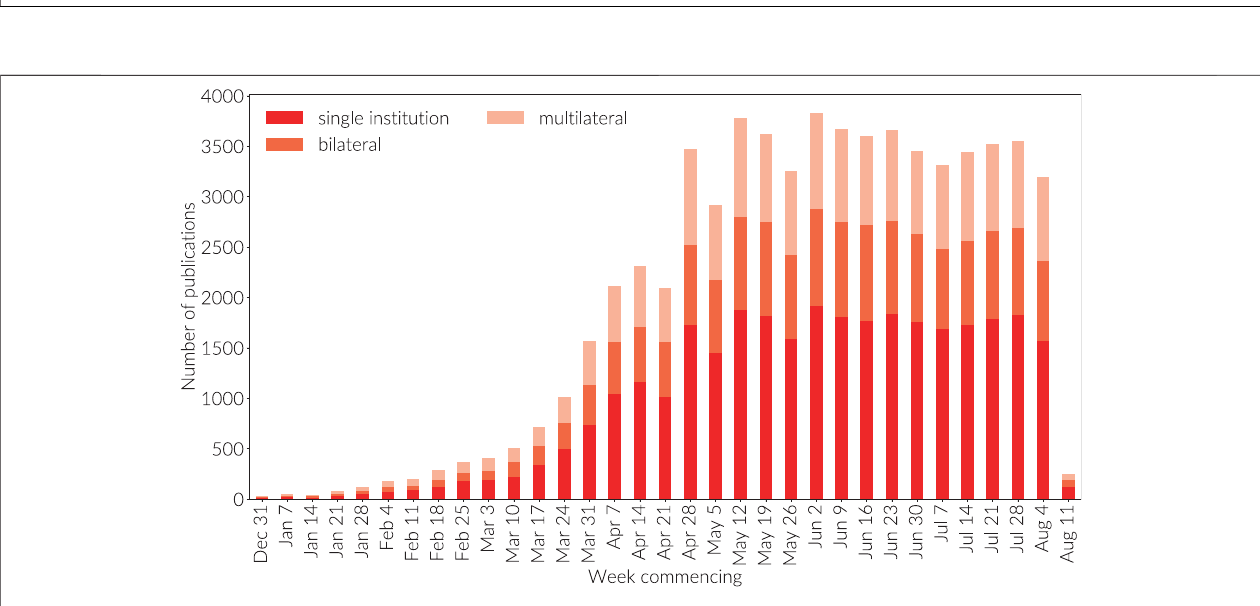
FIGURE 9 | Institutional collaboration modes for COVID research. This graph is not cumulative. Papers are grouped by the week commencing on the dates given; the fi nal week is incomplete. Publications counting toward ‘ single institution ’ have only a single institutional af fi liation, bilateral publications are af fi liated with two institutions,andmultilateralpublicationsarethosethatareaf fi liatedwithmorethantwoinstitutions.Thereisnosensitivityinthisplottothecountryinwhichinstitutionsare situated.